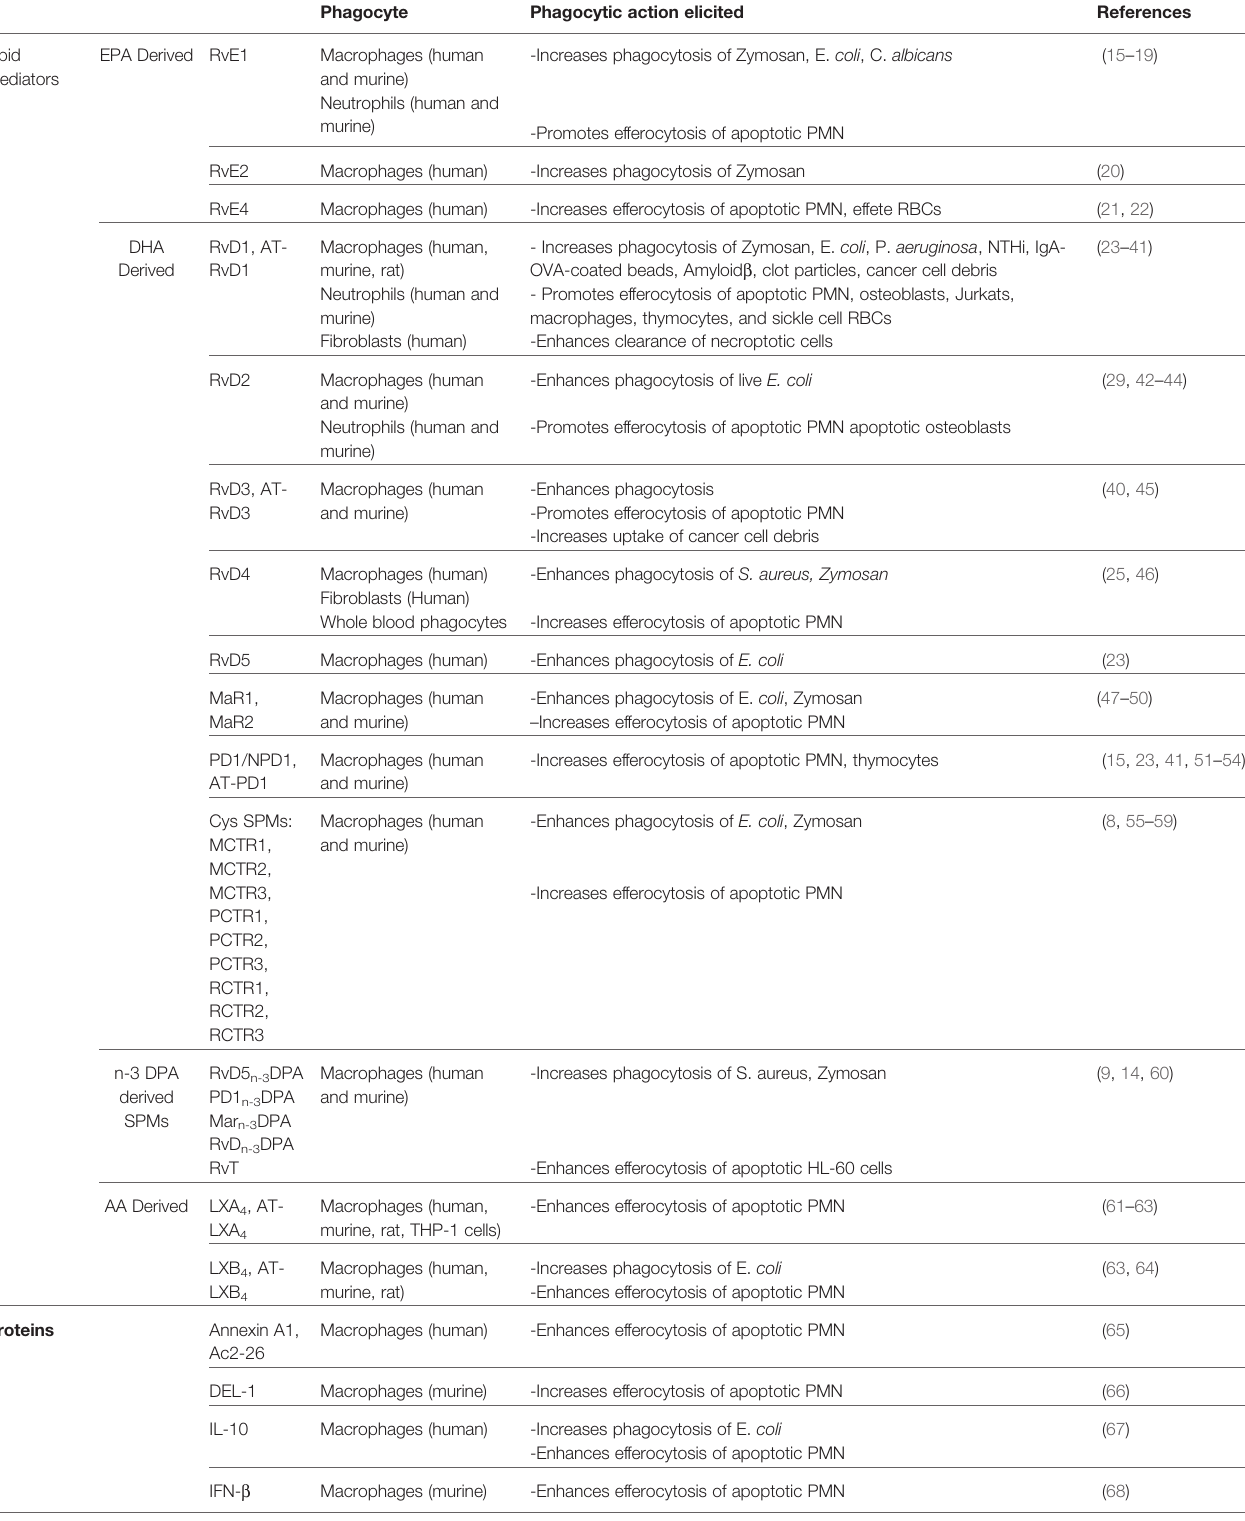
TABLE 1 | Pro-resolving factors that promote